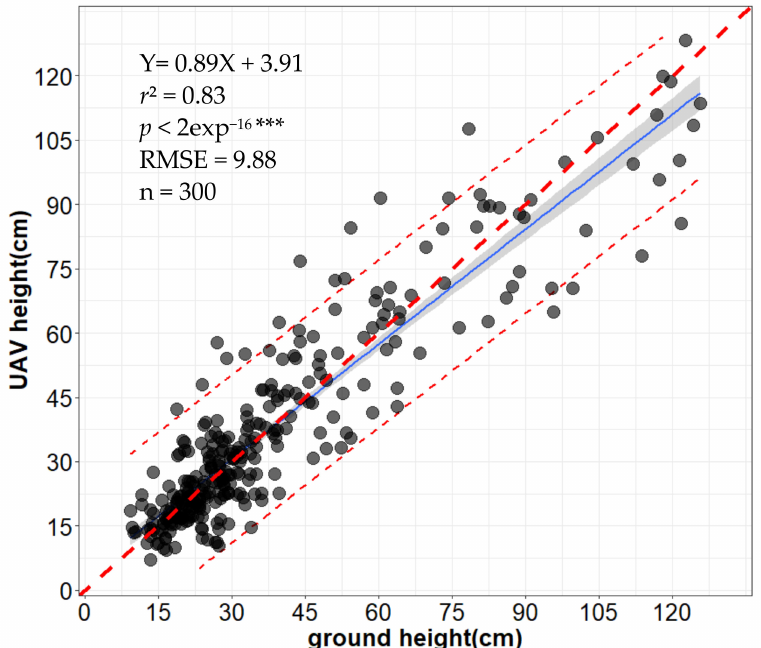
Figure 6. Regression plots between UAV-based and ground measurements plant height measured along crop cycle in 2018 field trial. r 2 : coefficient of determination and RMSE: root mean square error; *** significant at p < 0.001; exp: exponential; the dashed red line in the graph is the 1:1 line. dashed red lines represents the 95% confidence interval of the